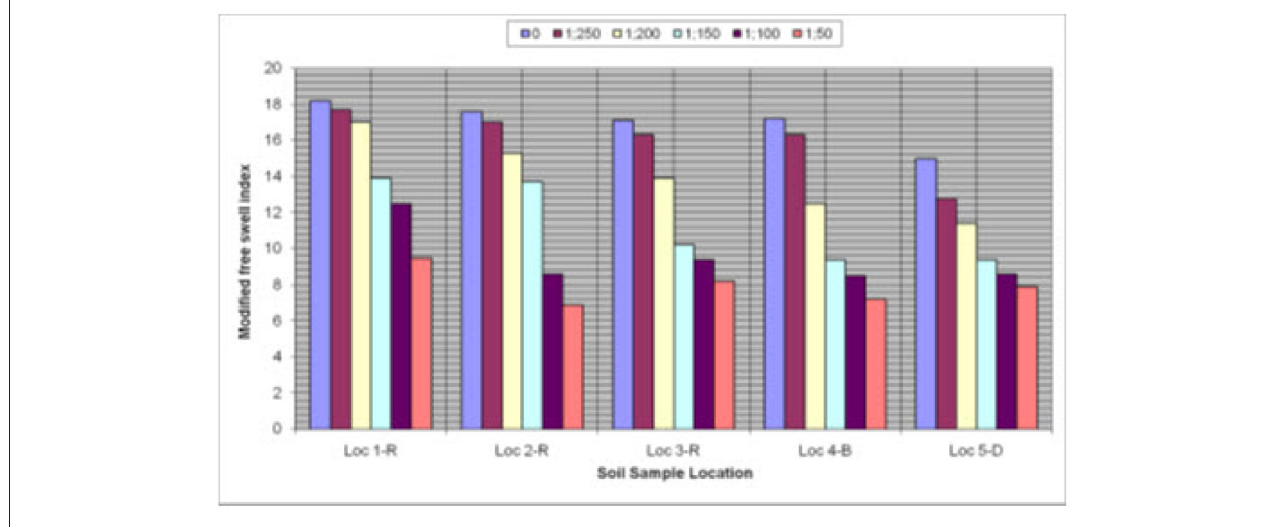
FIGURE 3 | Effect of addition of nanomaterial on modified free swell.